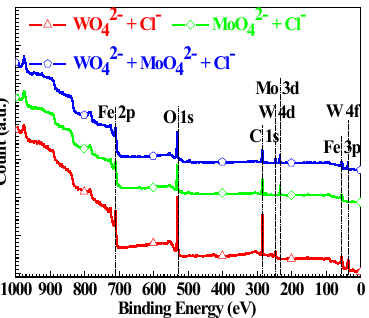
Figure 6. Wide-scan XPS of the Q235 samples polarized to E p in WO 4 2− + Cl − , MoO 4 2− + Cl − and WO 4 2− + MoO 4 2− + Cl − solutions.